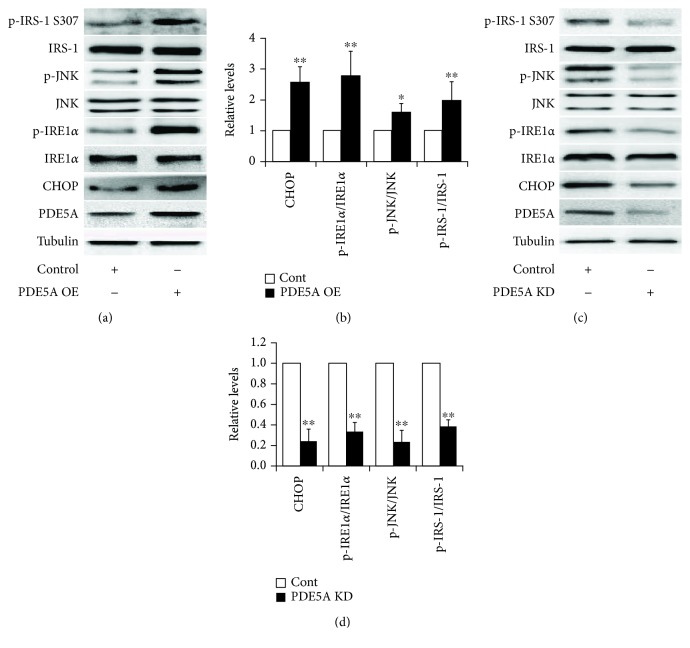
Effects of PDE5A on ER stress in C2C12 myotubes. (a) Representative western blots showing the ER stress markers and the phosphorylation of JNK and IRS-1 S307 in the cells with PDE5A overexpression (OE); (b) quantification of the protein or phosphorylated protein levels in (a); (c) representative western blots showing the ER stress markers and the phosphorylation of JNK and IRS-1 S307 in the cells with PDE5A knockdown (KD); (d) quantification of protein or phosphorylated protein levels in (c). N = 4. ∗P < 0.05, ∗∗P < 0.01 vs. the control group.